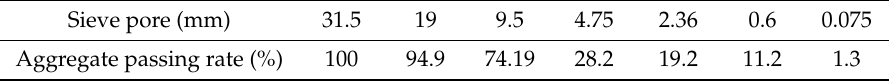
Table 2. The aggregate gradation of cement-stabilized